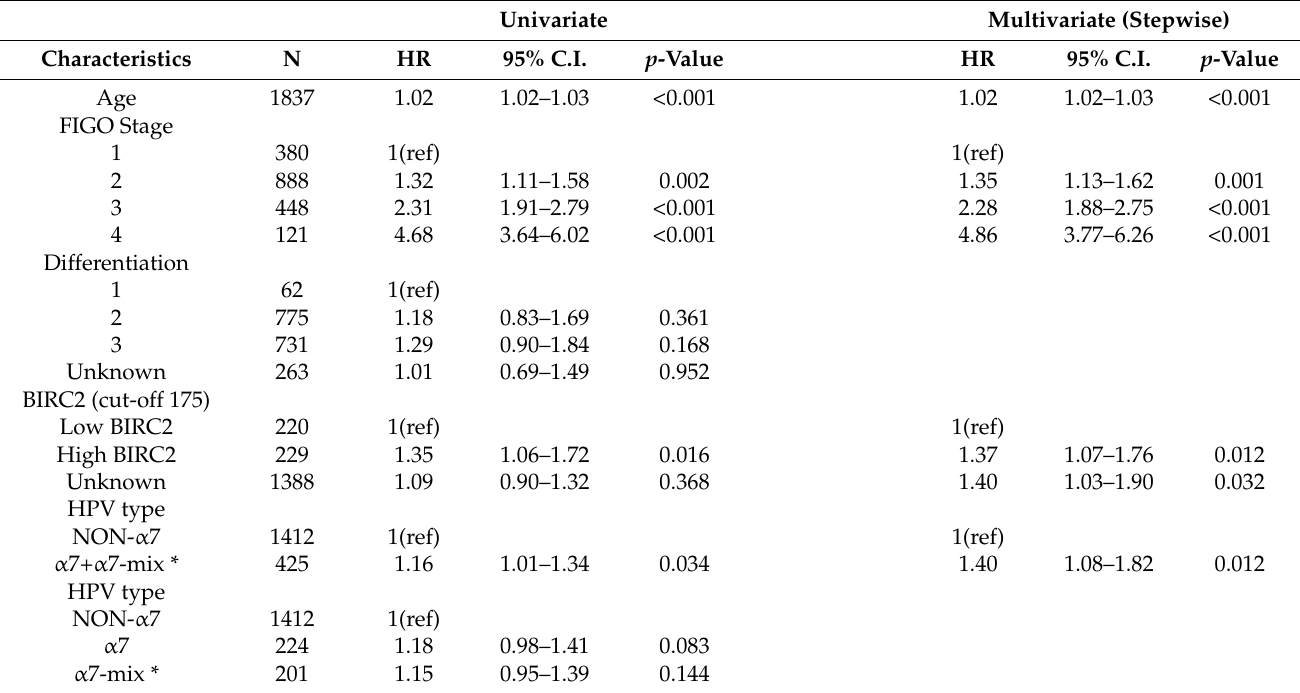
FIGO: International Federation of Gynecology and Obstetrics. * α 7-mix indicates multiple infections with at least one α 7-HPV and at least one non- α